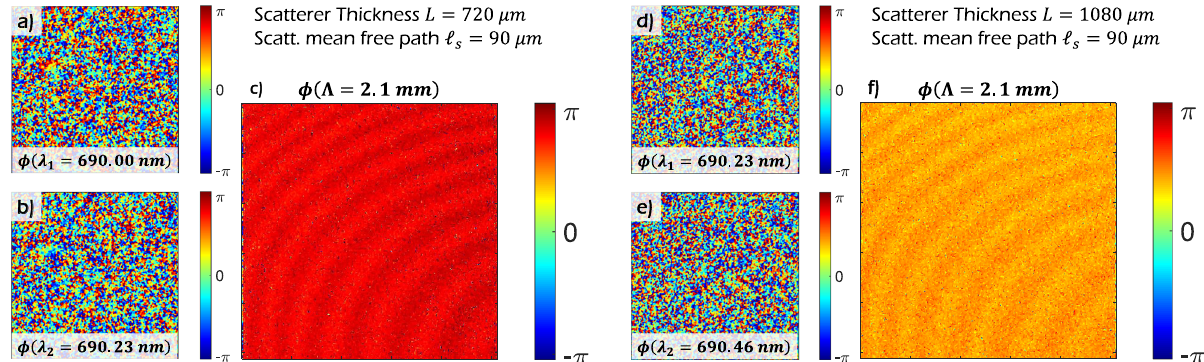
Fig. 5 Experimental demonstration of wavefront sensing through scatter using SWH. The data for this experiment where captured by the authors of Kadobianskyi et al. 72 without the intention to be used for our approach. Nevertheless, our SWH reconstruction mechanism is able to recover residual phase variations in speckled wavefronts emerging from volumetric scattering samples. a and b Scattered (speckled) phasemaps ϕ after the volumetric scattering sample with thickness L = 720 μ m and scattering mean free path ℓ s = 90 μ m for two different wavelengths λ 1 = 690.00nm and λ 1 = 690.23 nm. c Calculated synthetic phase map for Λ = 2.1 mm. d – f Same experiment with scatterer of different thickness ( L = 1080 μ m) and optical wavelengths λ = 690.23 nm and λ = 1 1